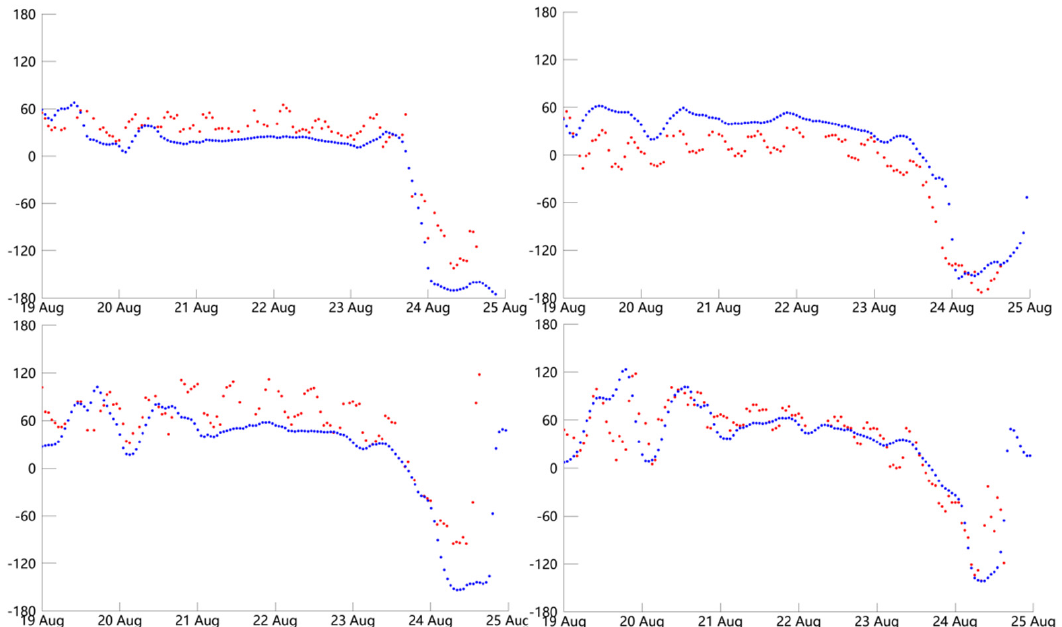
Figure 7. The temporal distributions of wind directions (degree) obtained from experiment 26 (blue